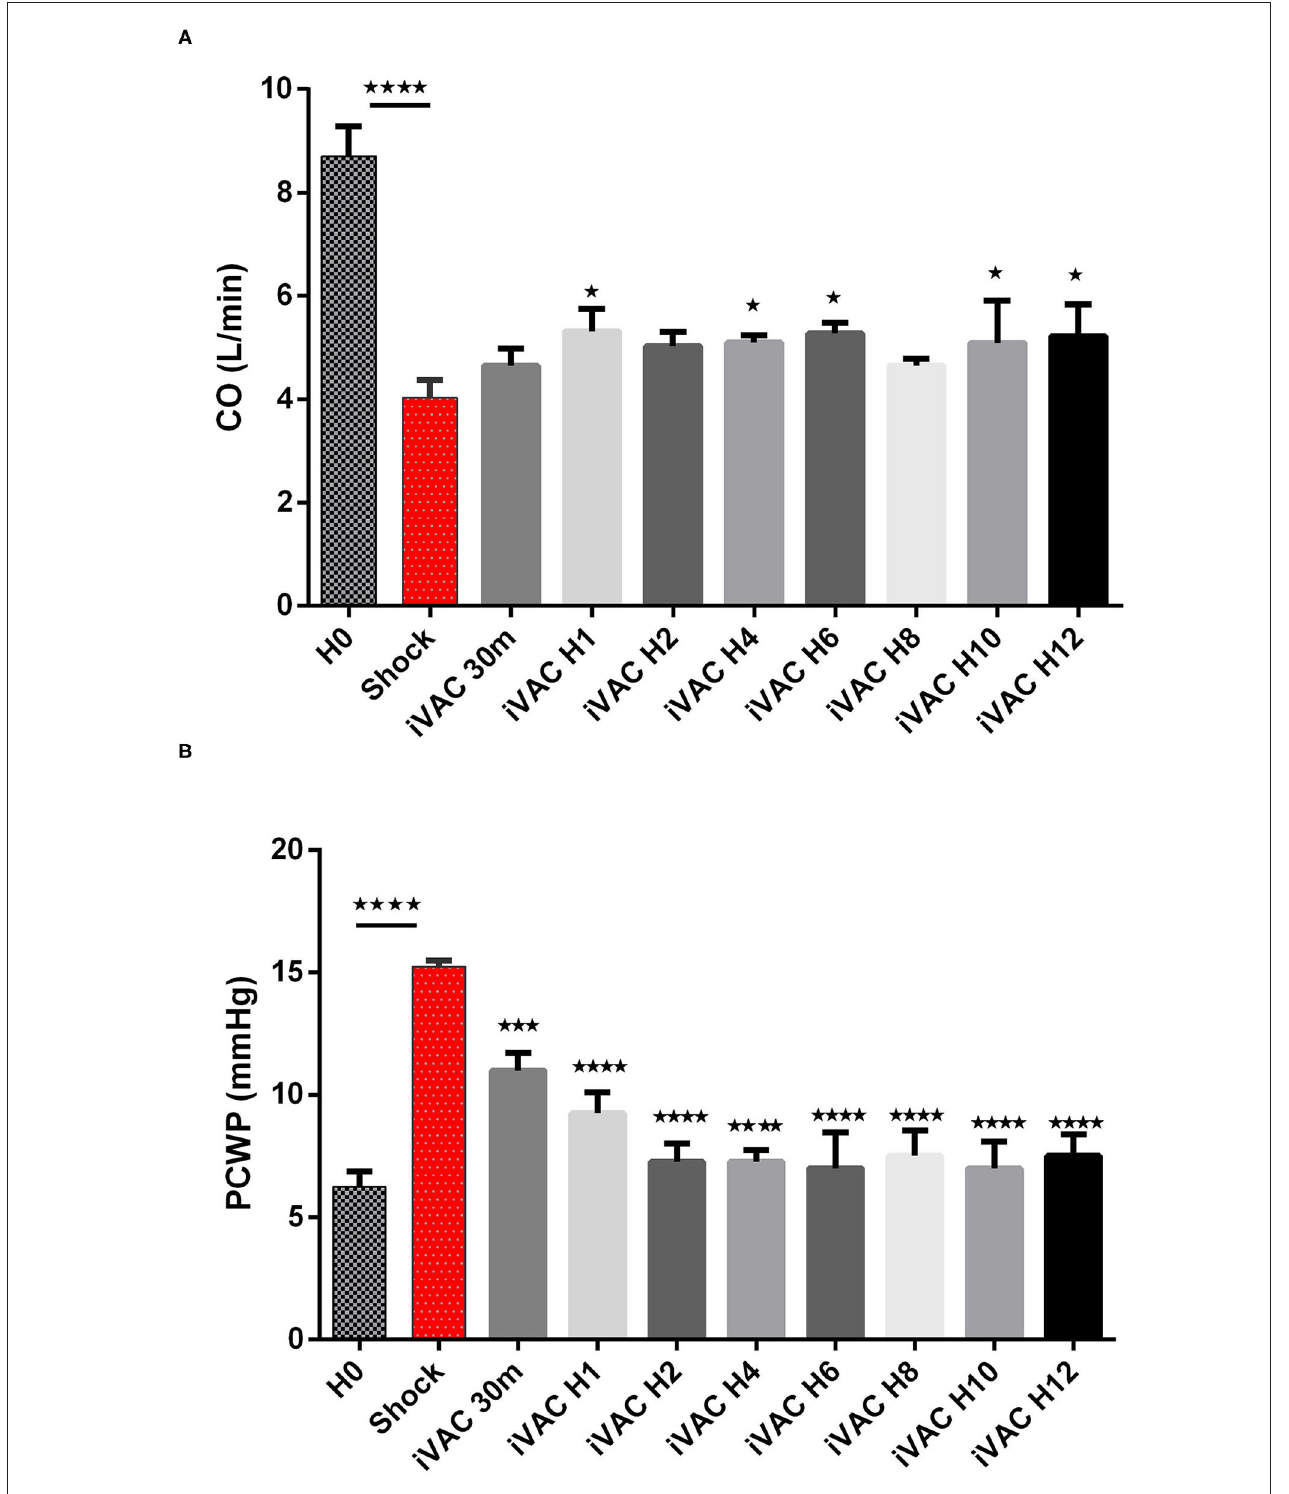
FIGURE 6 | Evolution of cardiac output (A) and PCWP (B) in CS pigs before and after IVAC2L support. Parameters are presented as mean ± SEM ( n = 4). The values of p were obtained by comparing the first baseline data to CS data, and second by comparing CS to others time points under IVAC2L support to CS onset (H4, H12). ⋆ p < 0.05, ⋆⋆⋆ p < 0.001 vs. shock, and ⋆⋆⋆⋆ p < 0.0001. CO, cardiac output; H0, baseline; H1, 1 post CS; H4, 4h after CS; H12, 12h after CS; PCWP, pulmonary capillary wedge pressure; SEM, standard error.